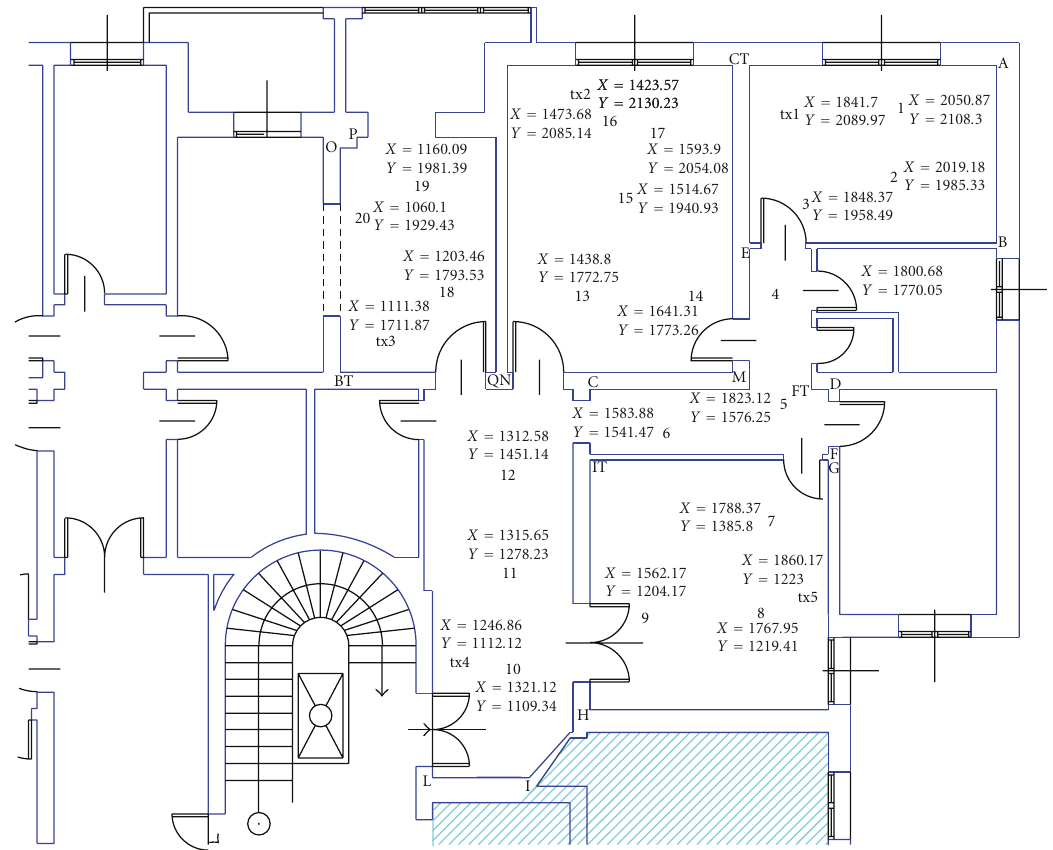
Figure 1: The measurement environment at the WiLAB, University of Bologna, Italy. Coordinates are expressed in centimeters.